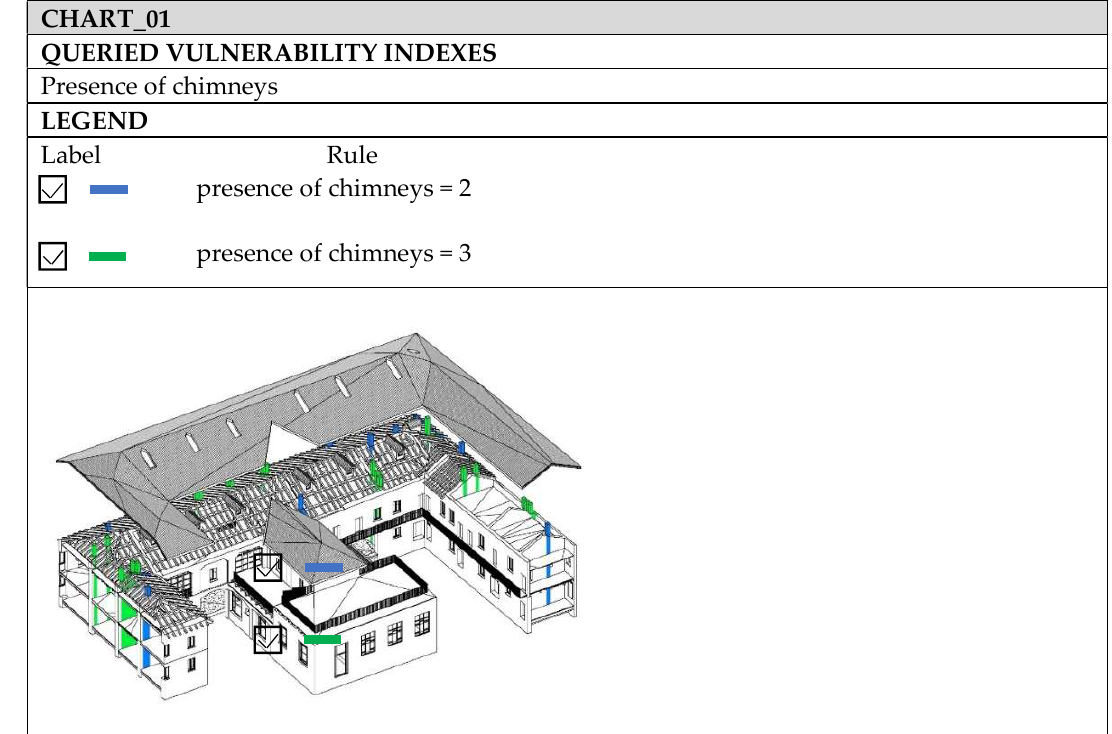
Figure 10. Simple query: presence of flue pipes and their degree of incidence on the vulnerability of the wall panel.